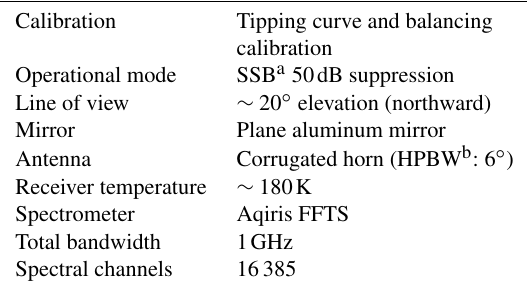
Table 1. MIAWARA technical